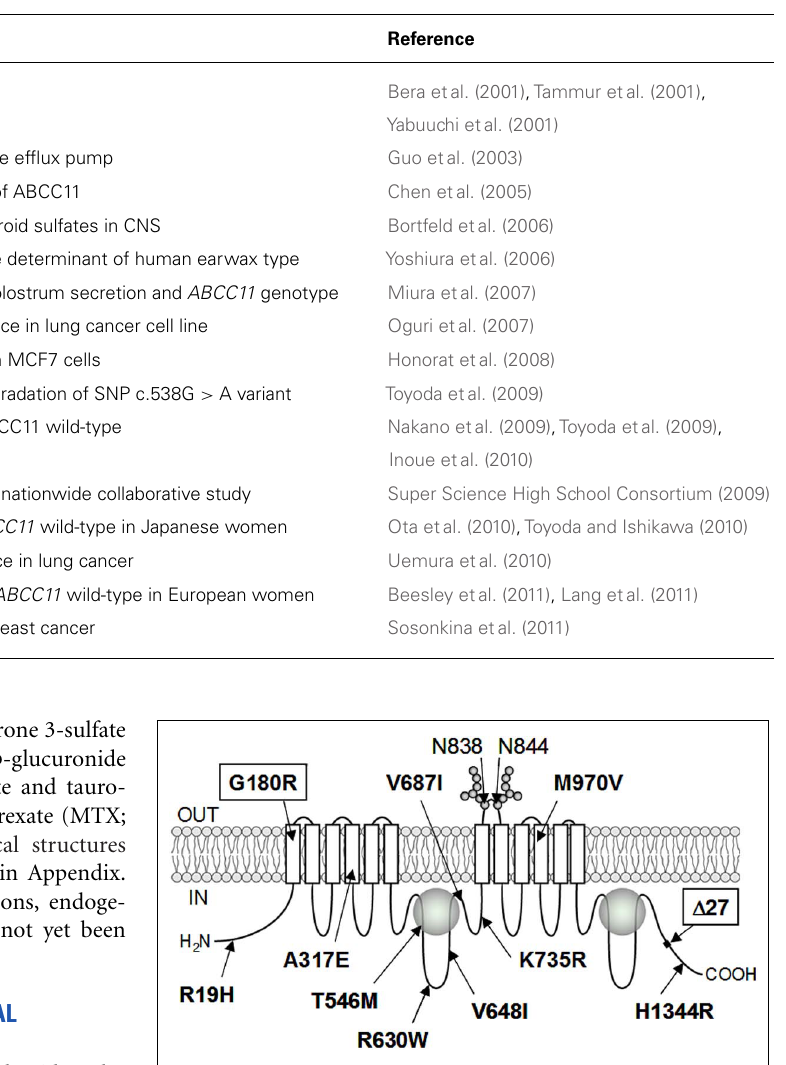
Table 1 | Historical overview on identification of the ABCC11 gene and its function.